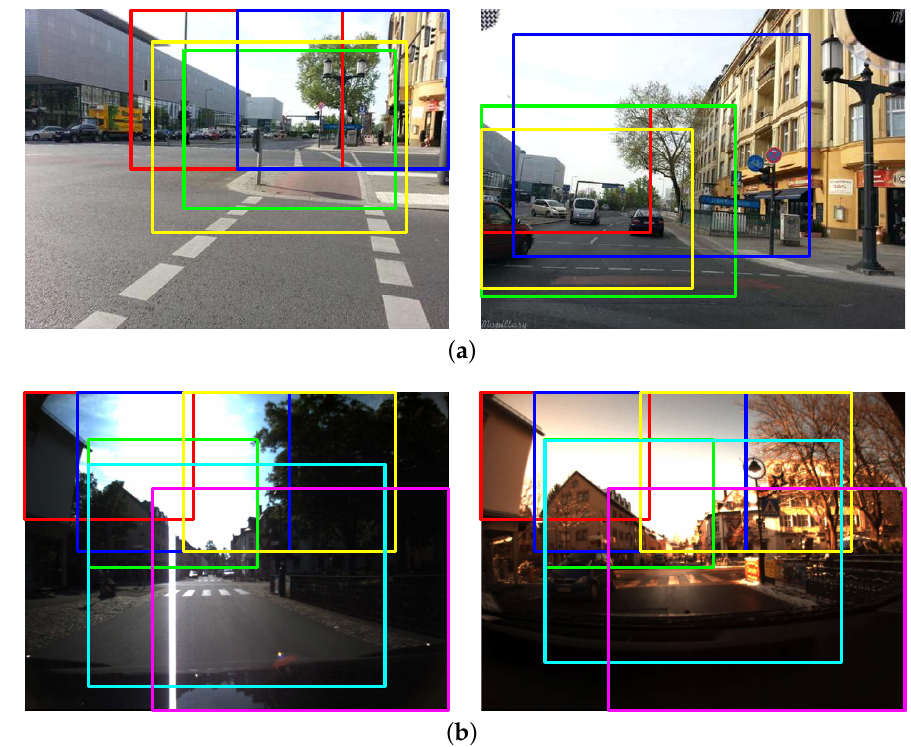
Figure 8. Examples of matched images with extracted and matched landmarks by our MSW method from: ( a ) Mapillary Berlin dataset; and ( b ) Freiburg Across Seasons dataset. The matched landmarks on Mapillary Berlin dataset are from different scales, while they have same scales on Freiburg Across Seasons